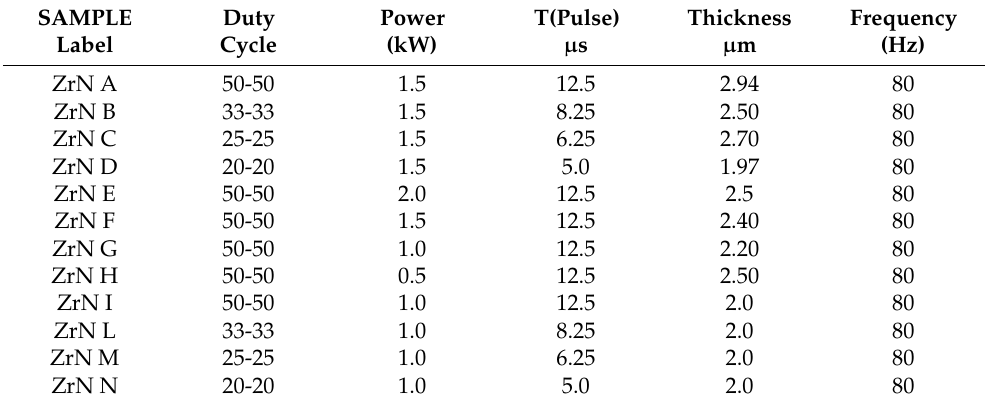
Table 1. All the main deposition parameters are resumed for the ten samples deposited using BPDMS.